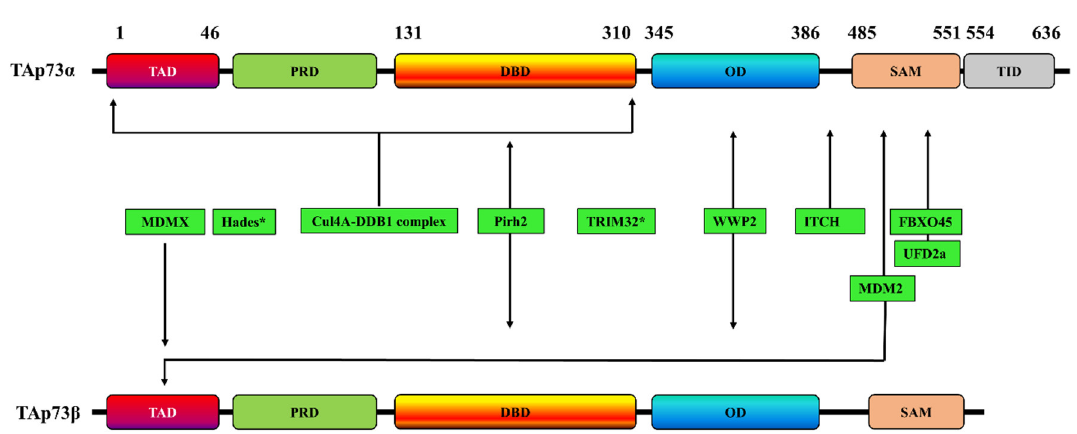
Figure 2. Schematic representation of the interaction sites of various E3 ubiquitin-ligases with TAp73 α , TAp73 β , or both. * indicates that the p73 interaction site is unknown. TAD: transactivation domain; PRD: proline rich domain; DBD: DNA binding domain; OD: oligomerization domain; SAM: sterile alpha motif; TID: transactivation inhibitory domain. Table 1. Role of E3 ligases in p73 stability. TRIM32: tripartite motif 32; Cul4A: Cullin4A; MDM2: mouse double minute 2 homolog; Pirh2: p53-induced RING-H2 protein. E3 Ligase